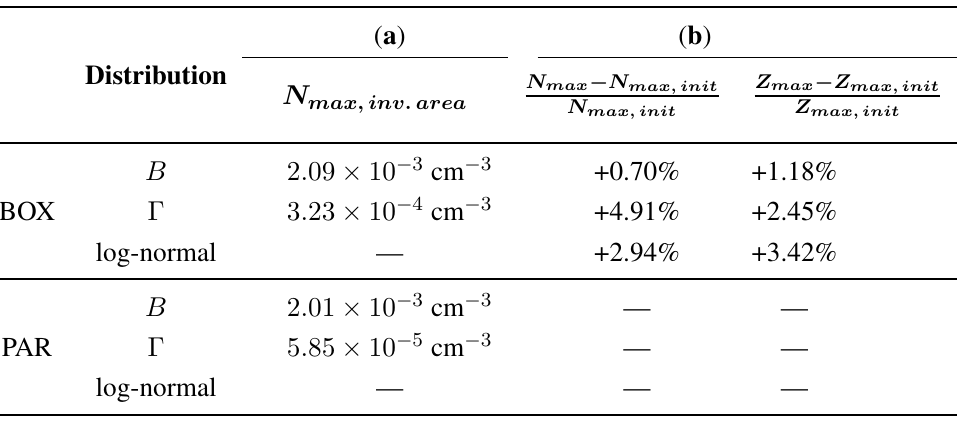
Table 3. ( a ) Invariant-signal area: maximum value of the number density; ( b ) the maximum value of the signal is greater than the initial value: the relative difference to the initial value as a